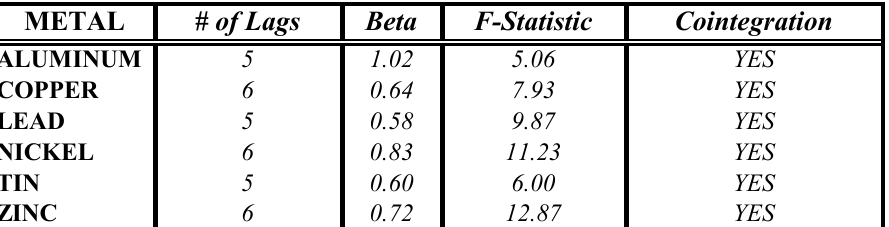
TABLE 5 – Pesaran Cointegration Tests Table 5 reports the results of test statistics about the cointegration of the data series. Specifically, the Pesaran cointegration test (1997) is run. The test employed has two variables (k), an intercept and no trend. The 10% critical value is 4.14 in this case. Cointegration was also found to be the case in Engle-Granger tests using ADF and the Engle-Granger test